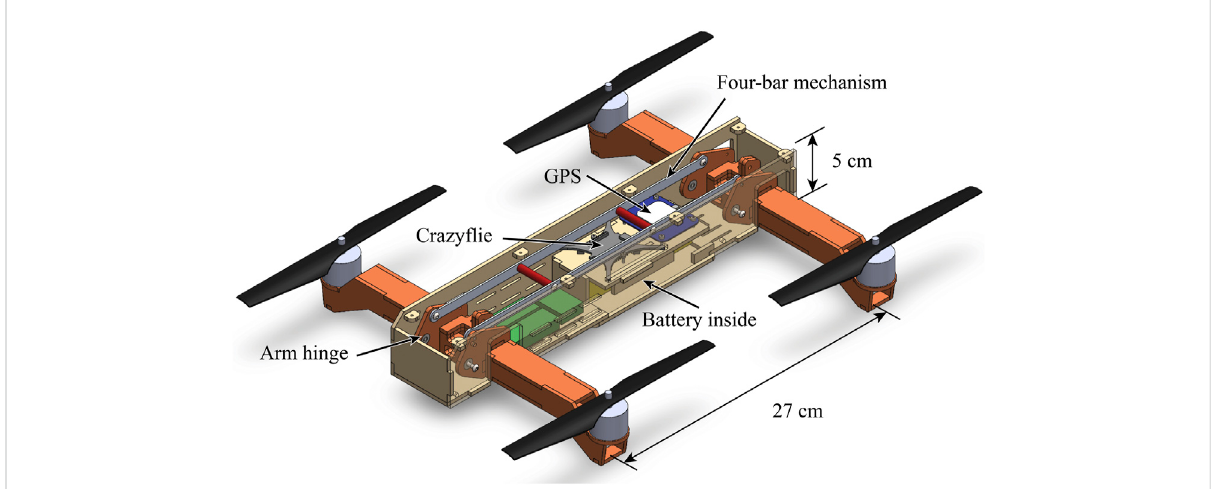
FIGURE 7 The experimental vehicle frame with the top cover plate taken off. The fuselage shown in beige is constructed with laser-cut wood. The arms showninredorangeareallowed torotatearound thearmhinges, andtherotationsofthefrontandreararms arecoupledbyafour-bar mechanism. Roundstand-offsshowninredareinstalledonthelongconnectingrodofthefour-barmechanismtopreventbuckling.Slotsarecutonthefuselage for zip-tying wires and other electronics including the ESCs shown in